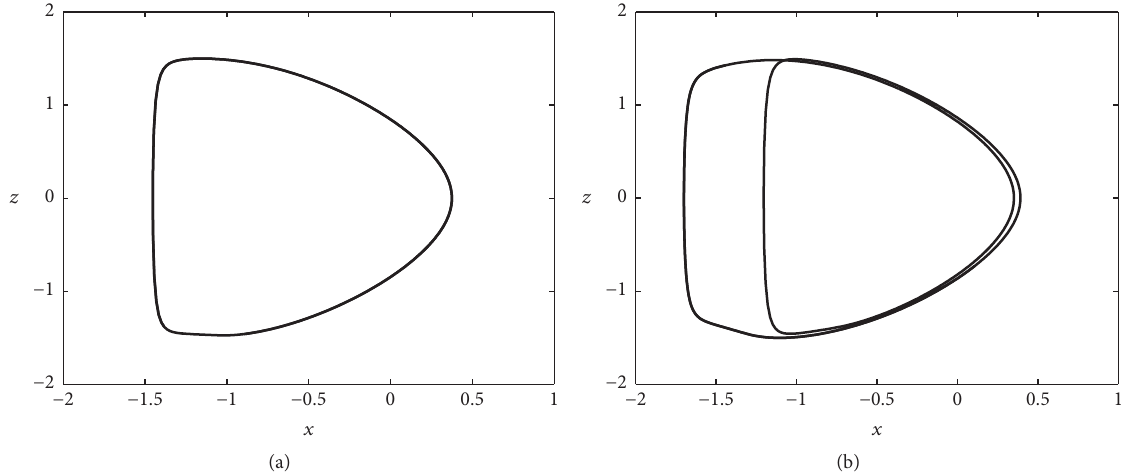
Figure 6: Periodical behavior of system (9) represented in the 𝑥 - 𝑧 plane: (a) period–1 state ( 𝑏 = 3.25 ) and (b) period–2 state ( 𝑏 = 2.95 ).